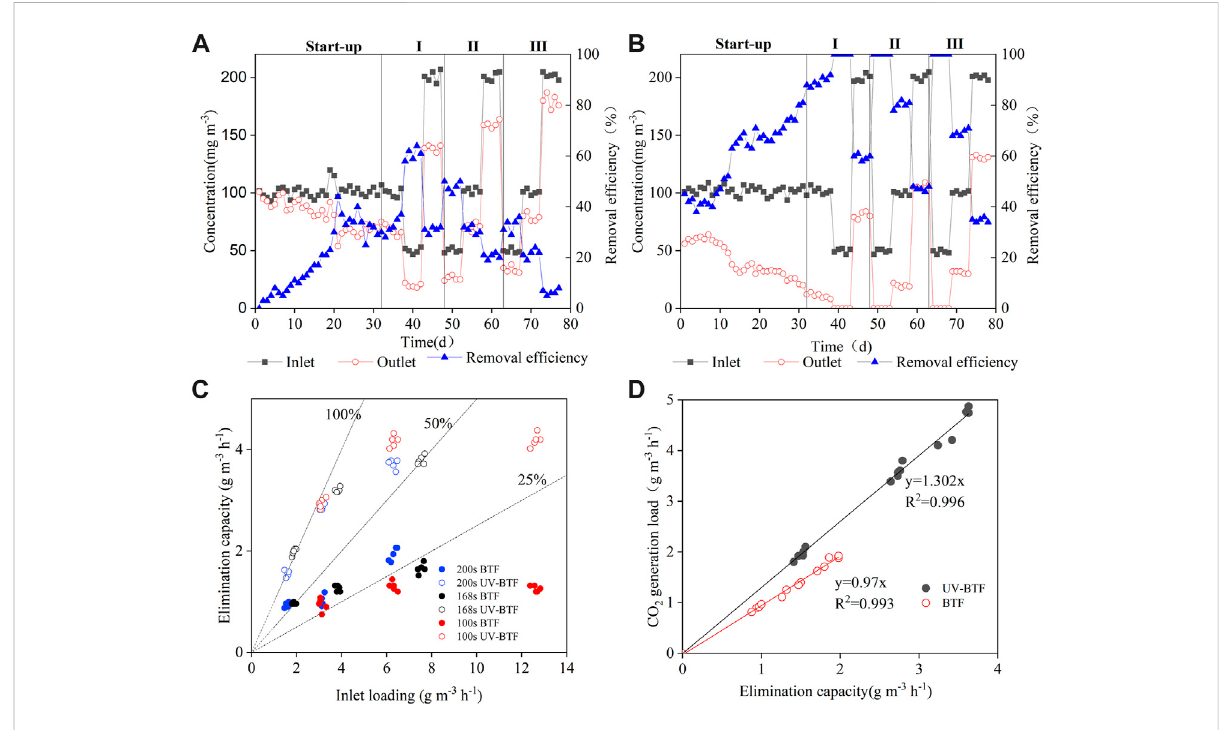
FIGURE 2 Overall performance of the single BTF (A) and the combined UV-BTF (B) during the start-up and stable operational periods. Performances (C) and CO 2 productions (D) at different inlet loads and EBRTs during the whole